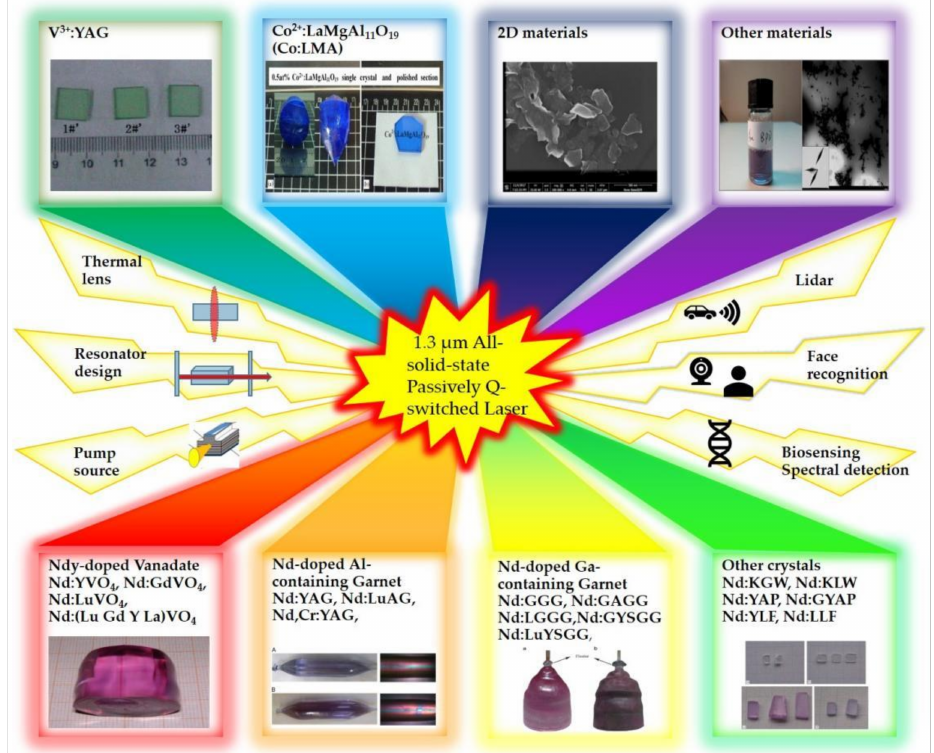
Figure 1. Composition and application of 1.3 µ m passively Q-switched laser. V:YAG samples [8], Co 2+ :LaMgAl 11 O 19 crystal and polished section [9], SEM image of MoS 2 -SA [10], Photograph of gold nanobipyramids solution and TEM image of the gold nanobipyramids [11], Nd:YVO 4 crystals samples [12], Nd:YAG crystals samples [13], Nd:GGG crystals samples [14], Nd:KGW crystals samples